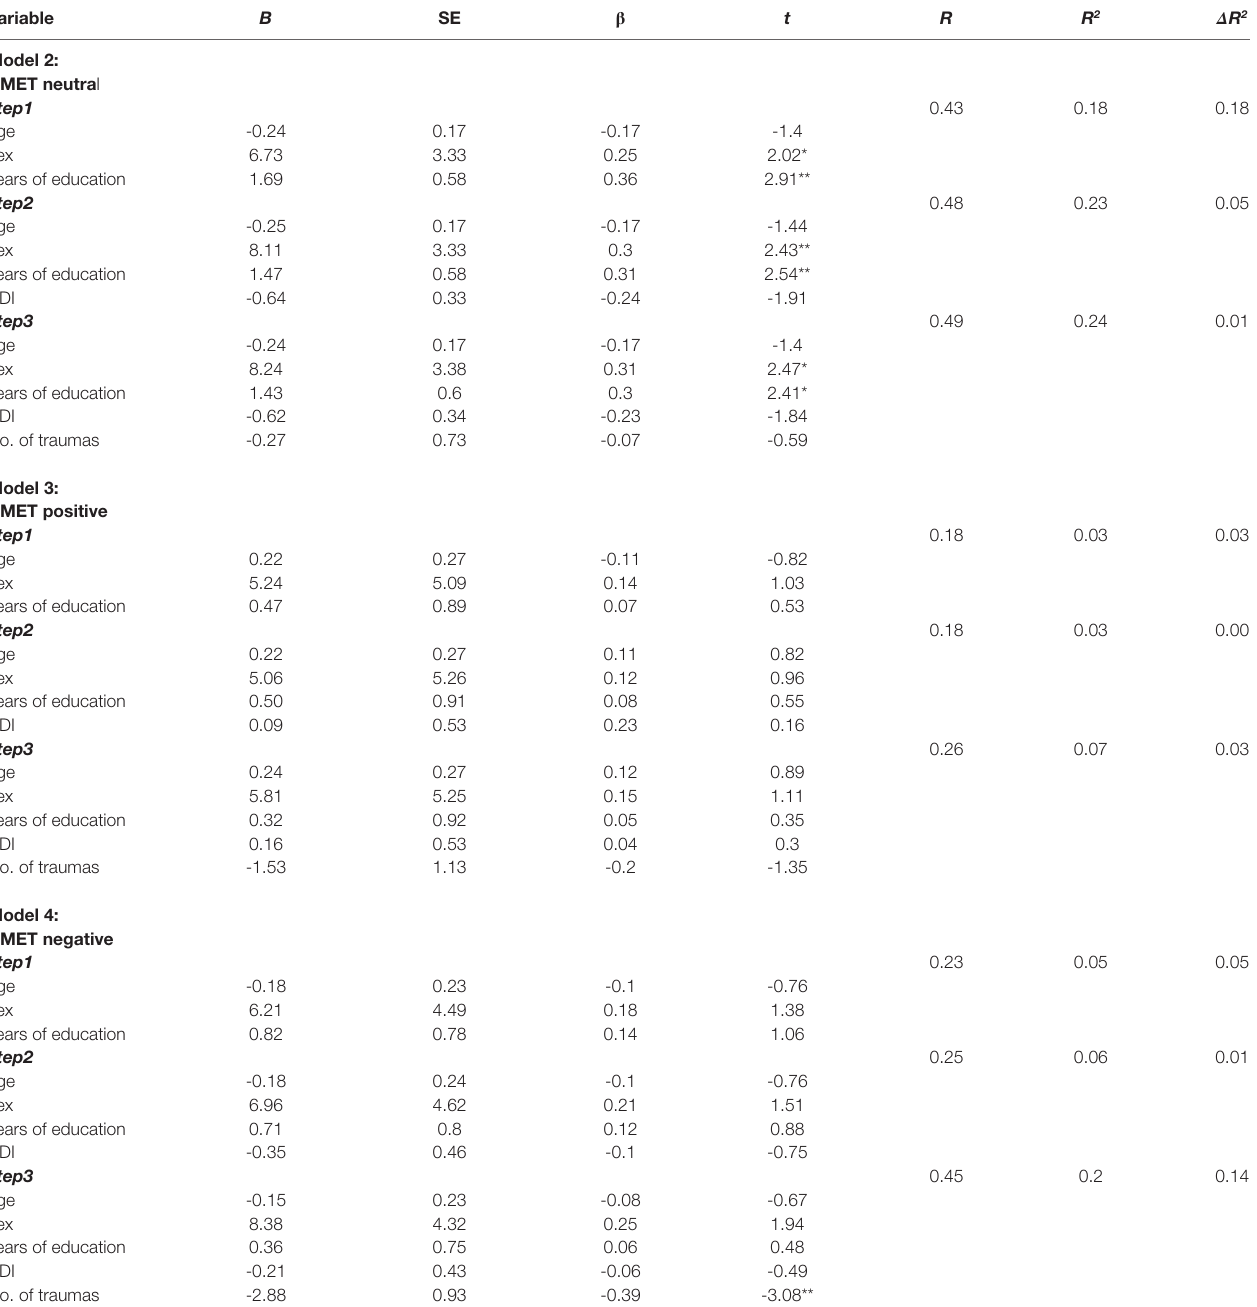
TABle 6 | Summary of hierarchical regression analyses for variables predicting RMET